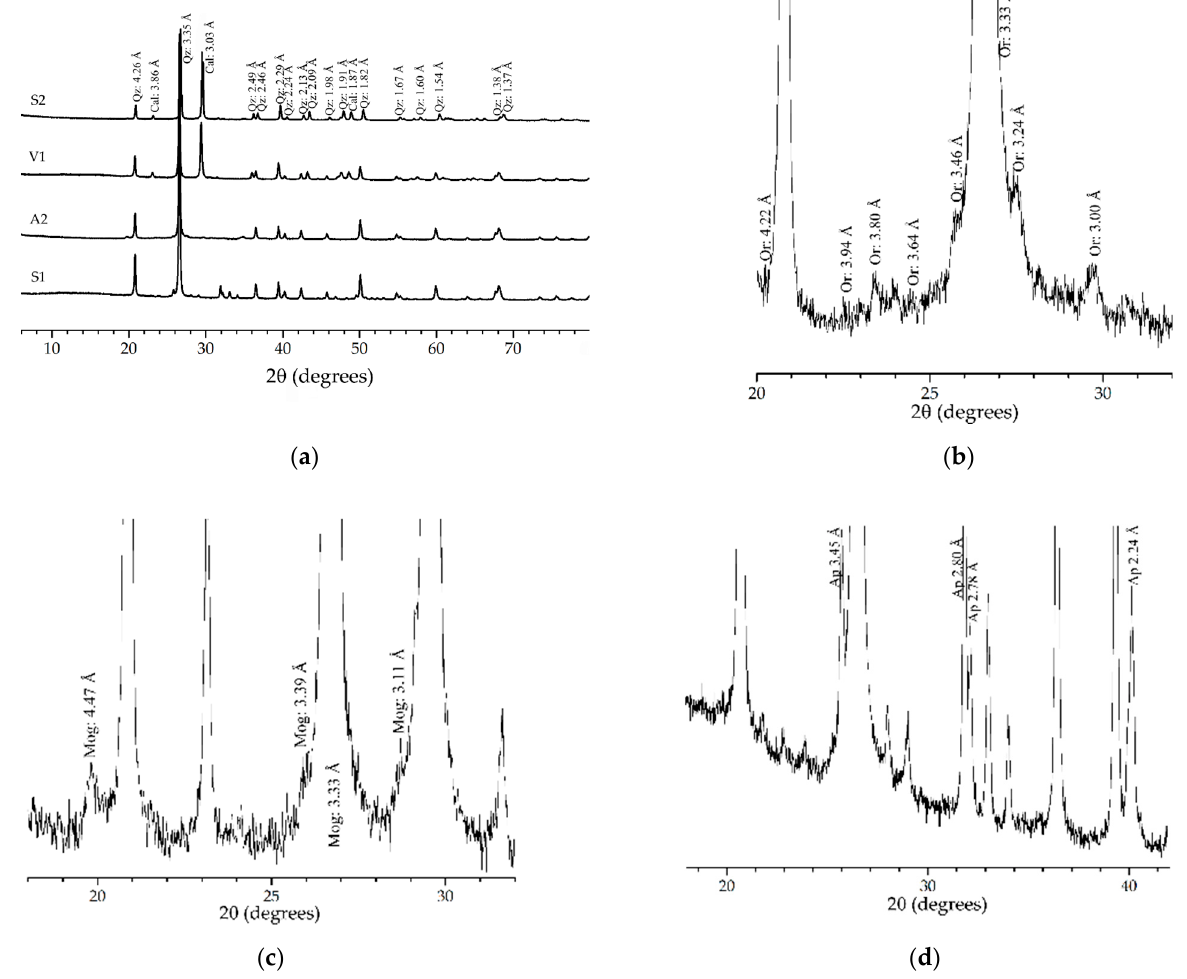
( d ) Figure 6. X-ray diffraction patterns of the chert samples from inland outcrops showing reflections of quartz, Qz, and cal- cite, Cal, ( a ); muscovite, Ms, ( b ); hematites, Hem, ( c ) and barite, Bart, ( d ).